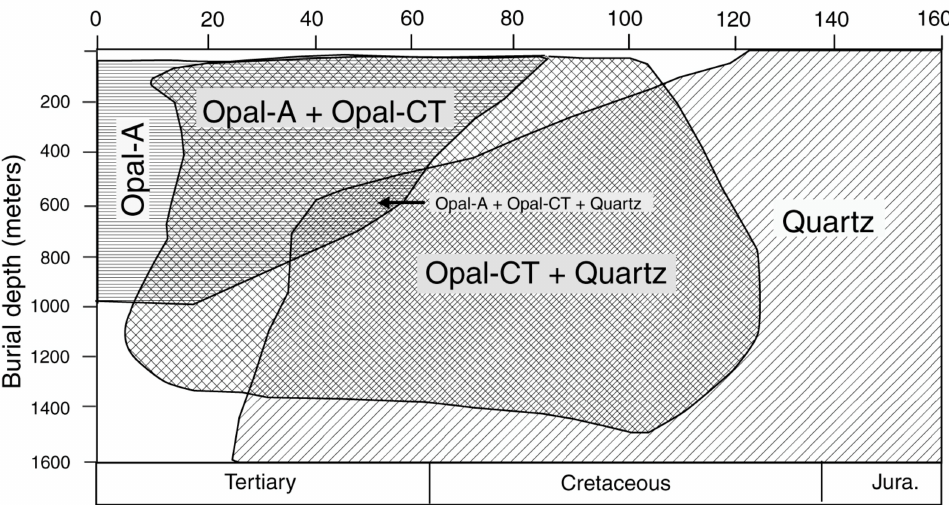
Figure 41. Worldwide distribution of silica polymorphs in deep sea sediments graphed with respect to geologic age. Graph adapted from Hesse [34]. Pure opal-A was only found in young Tertiary sediments. Diagenetic transformations of opal to quartz were inferred to be relatively slow. The broad opal-CT + quartz zone contrasts to continental deposits, where opal is generally absent in Mesozoic sedimentary environments. Perhaps reaction rates are very different for deep seafloor